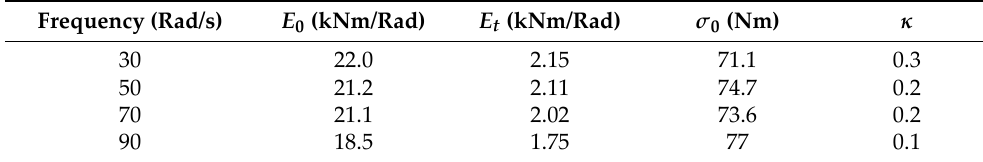
Table 4. The parameters obtained from the fit used in the Valanis model.